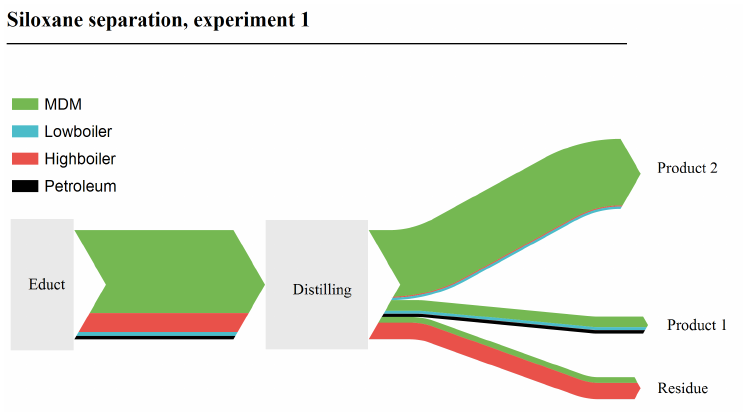
Figure 6. Sankey diagram of mass flows for distilling Experiment A.